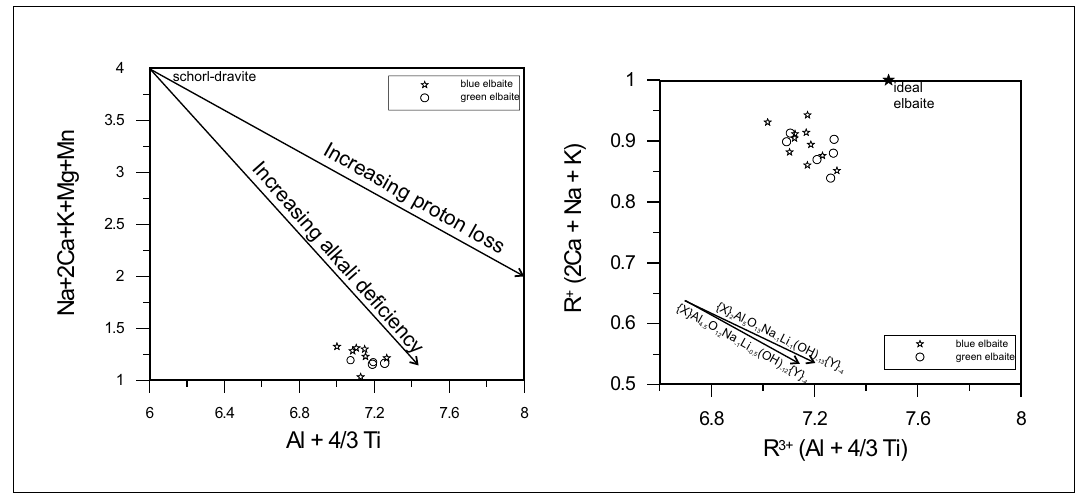
Fig. 5 – (a) R 3+ (Al + 4/3 Ti) vs. (R + + R 2+ ) (Na + 2Ca + K + Mg + Mn) diagram for elbaites of the Alto Quixaba pegmatite. Substitution trends are from Gallagher (1988). (b) R 3+ (Al + 4/3 Ti) vs. R + (Na + 2Ca + K) diagram for elbaites of the Alto Quixaba pegmatite. Substitutions trends are from Gallagher